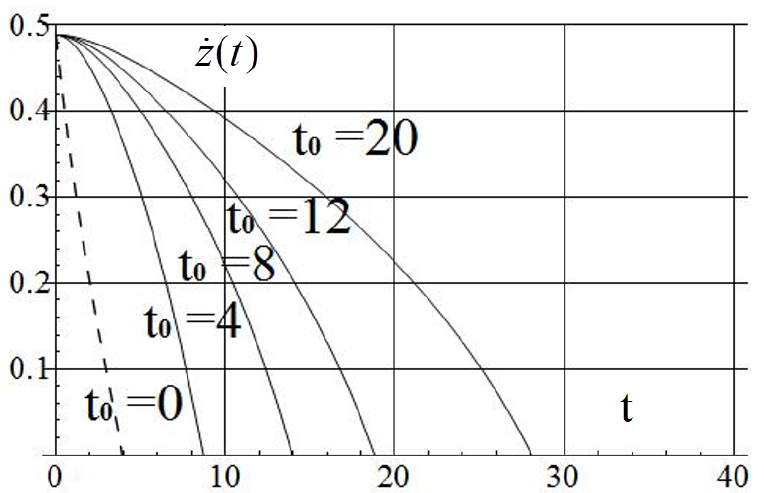
Figure 11. Submersion of the cylinder from the start of deceleration until complete stop accounting for the subsequent ascension for a change in relative buoyancy from − η to η and various t 0 , η = 0.01, l c = 1 m.